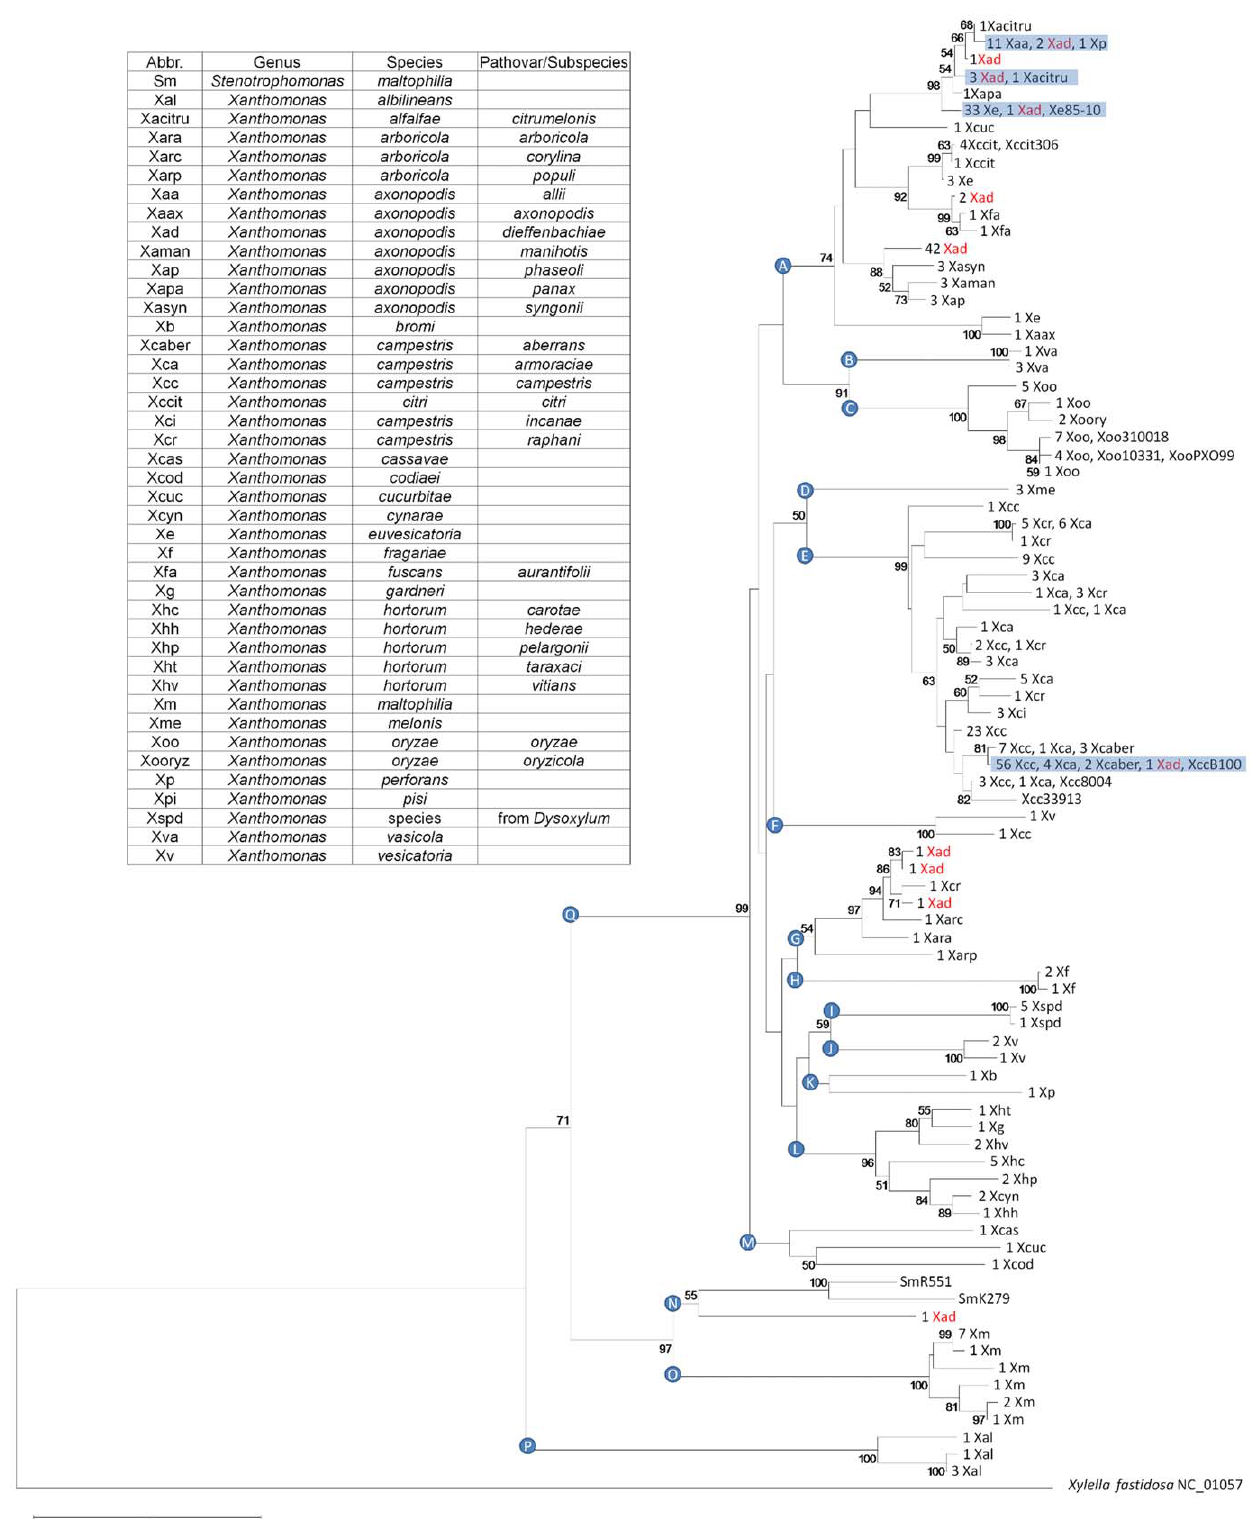
Figure 3. Classifying Xanthomonas based on RIF genotypes. The rooted neighbor-joining cladogram was constructed from 358 characterized Xanthomonas strains from the PBC (Table 2), ten reference strains from GenBank (see Table 1 for strain names) and the outgroup Xylella fastidiosa . Xanthomonas abbreviations are given in the text box. Identical sequences are represented only once and the number of sequenced strains is indicated on each leaf. Bootstrap values of . 50% (shown at the node) are expressed as a percentage of 5,000 replicates. Blue boxes contain strains of different species with identical RIF sequences. X. axonopodis pv. dieffenbachiae strains are found throughout the tree (red text).